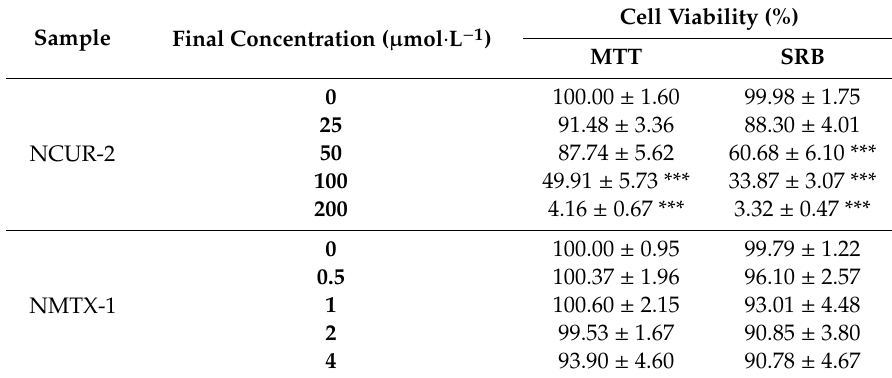
Table 2. Cell viability of Calu-3 by MTT and SRB assays after its treatment with NCUR-2 and NMTX-1 at di ff erent concentrations for 72